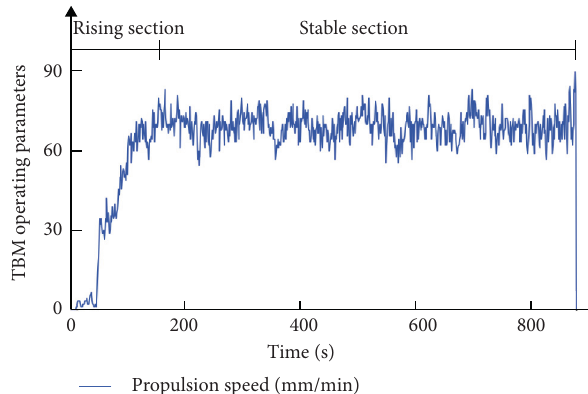
Figure 7: A complete tunneling cycle in TBM